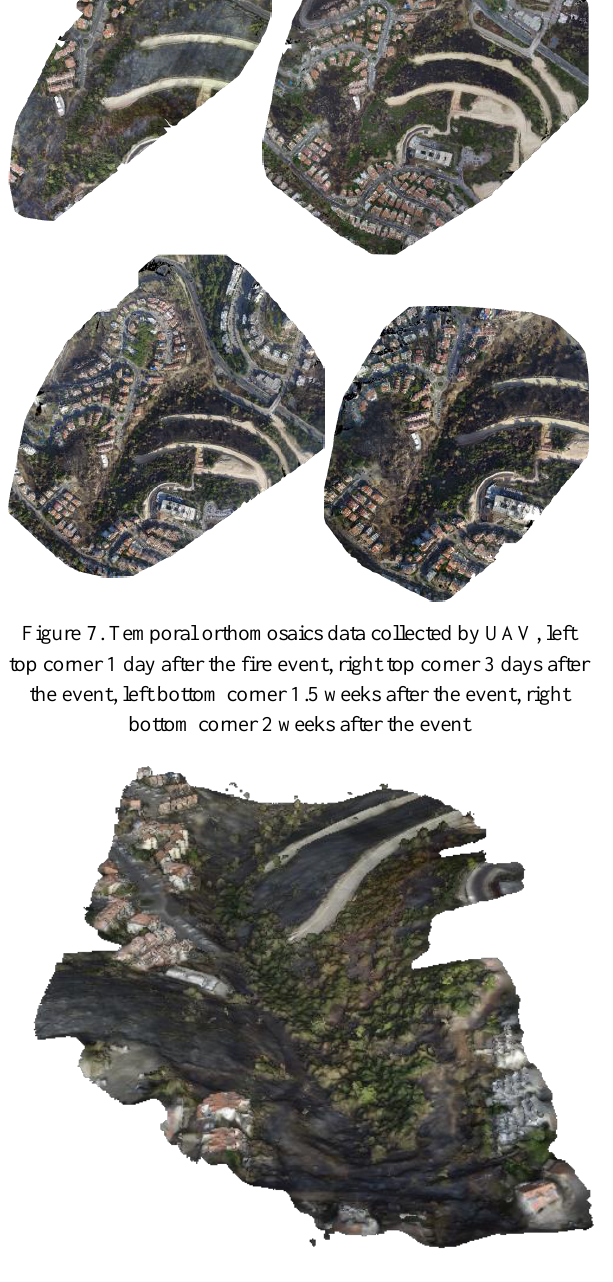
Figure 8. A 3-D point cloud retrieved from the imagery data collected by UAV and processed in Pix4D